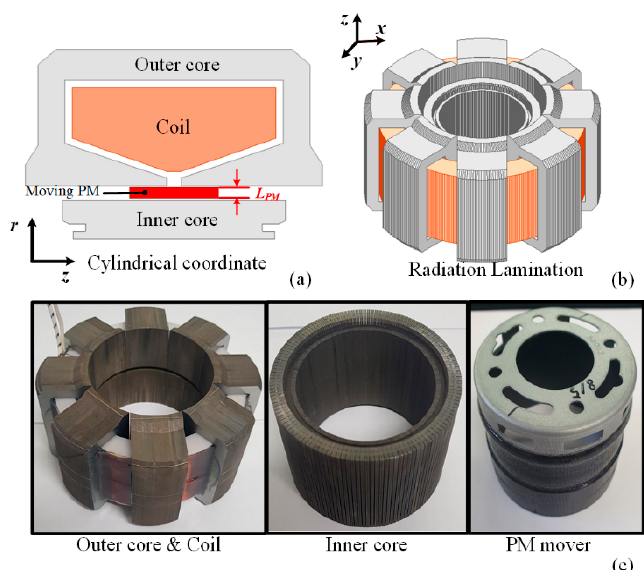
Figure 1. ( a ) Two-dimensional analysis model of LOM, ( b ) 3D analysis model of LOM, ( c ) manufac- tured components of linear oscillating machine.